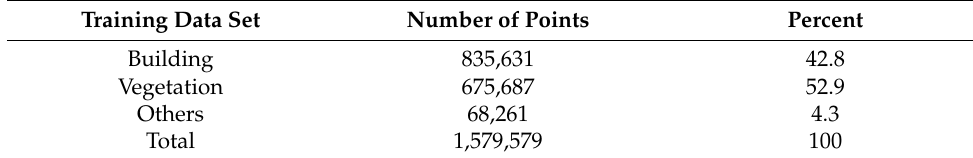
Table 4. Summary of the training data set classes.